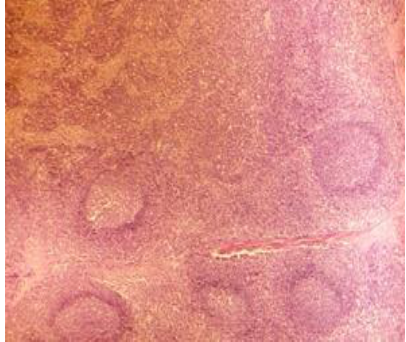
Figure 4: Longitudinal section of a prefemoral lymph node obtained from a cow infected with Theileria annulata parasites. It appears edematous and hemorrhagic.